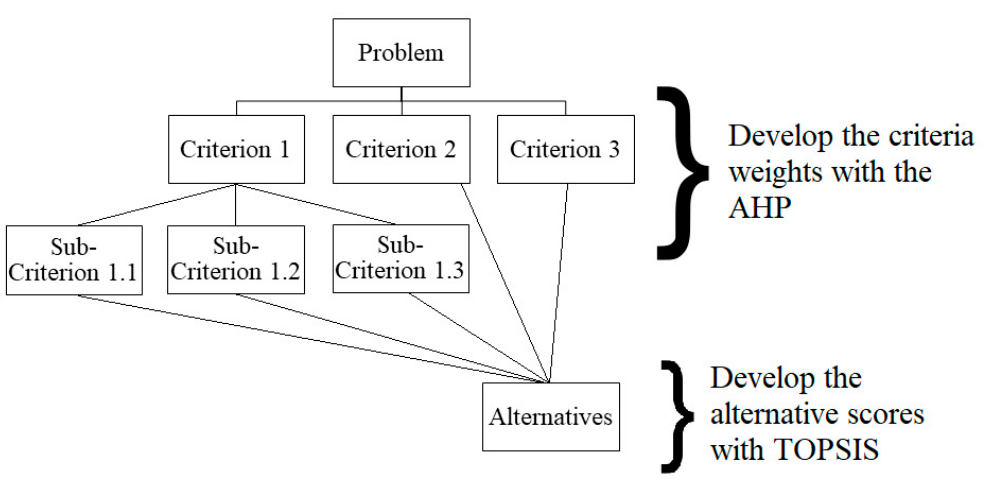
Figure 2. An MCDA decision hierarchy.